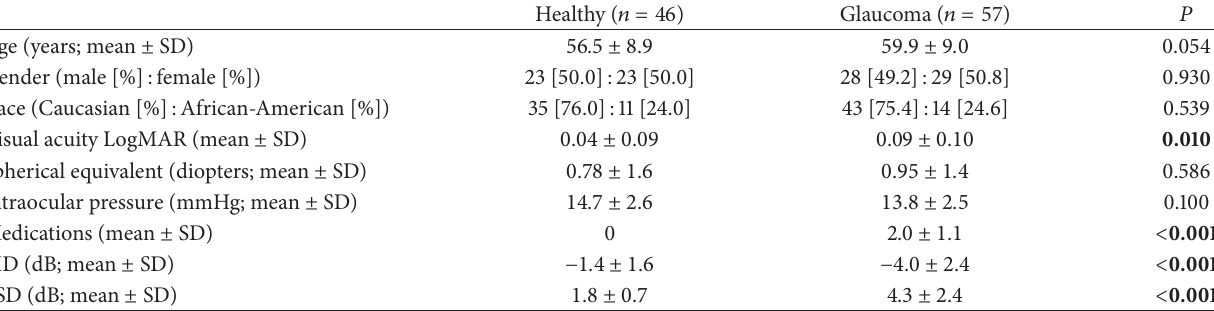
Table 1: Demographic characteristics of the healthy and glaucoma